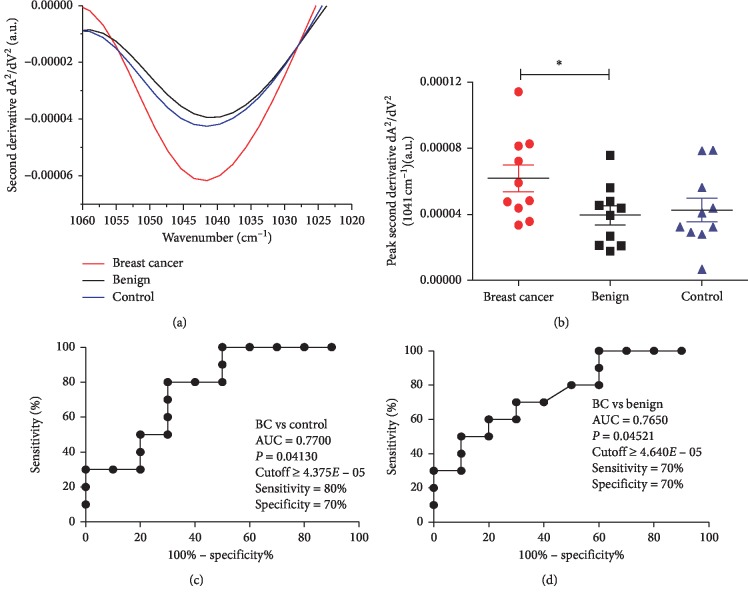
Comparison of the second-derivative absorbance of the statistically significant peak 1041 cm−1 between the three study groups. (a) Average second-derivative spectra between 1060–1020 cm−1 highlighting the wavenumber 1041 cm−1 for breast cancer (red line), benign breast disease (black line), and control saliva (blue line). (b) Scatter plot of the statistically significant wavenumber 1041 cm−1 for breast cancer (red), benign breast disease (black), and control saliva (blue). The line represents the mean, and the error bars (whiskers) represent the standard error of the mean (SEM) (∗P < 0.05, comparison of groups via the unpaired t-test with Welch's correction). ROC curves made from the wavenumber 1041 cm−1 for (c) breast cancer vs. control and (d) breast cancer vs. benign breast disease. Results about area under the curve (AUC), P value, cutoff, sensitivity, and specificity are being shown near the ROC curve. Statistically significant differences are represented by ∗ (∗P < 0.05).